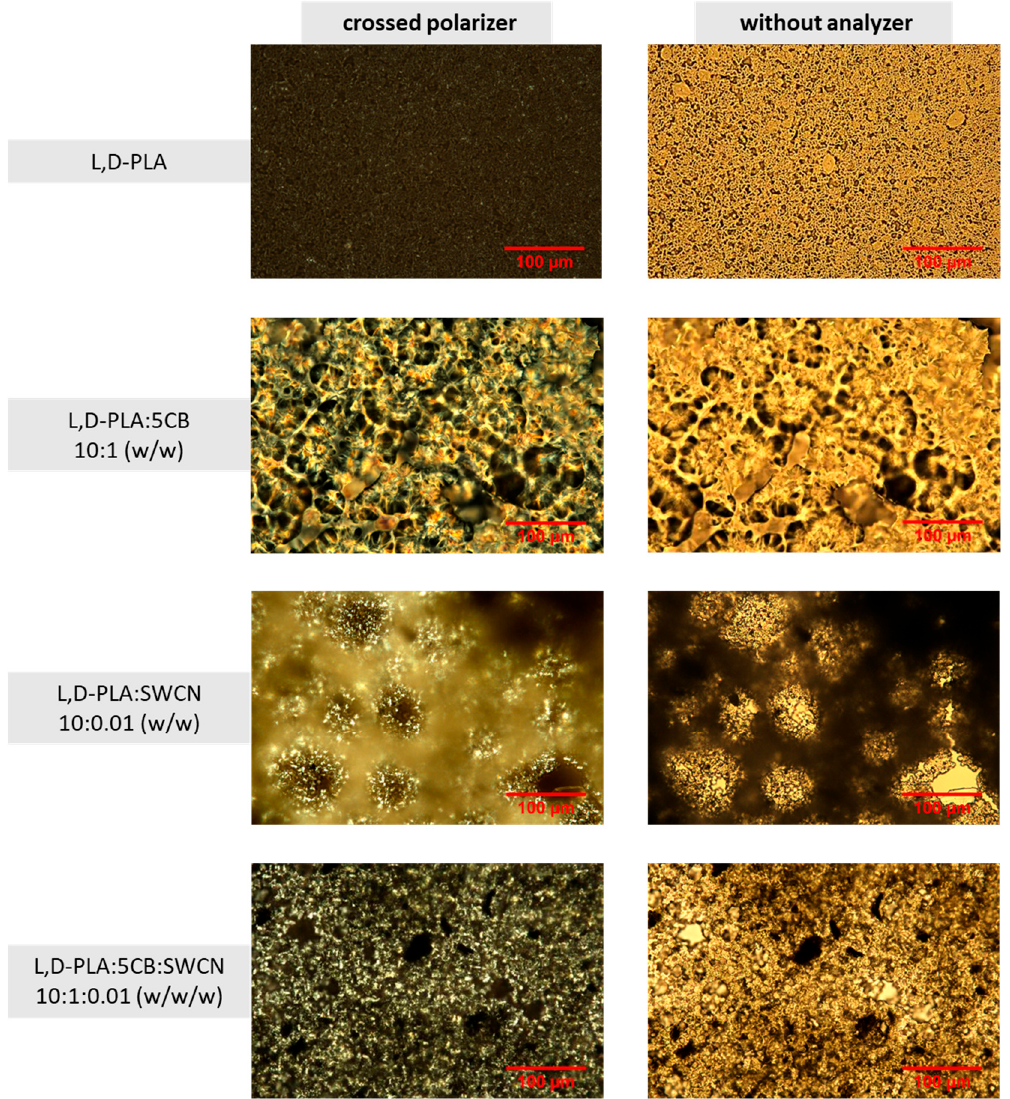
Figure 2. Optical textures of pure L,D-PLA and its hybrid layers registered with crossed polarizers and without an analyzer.